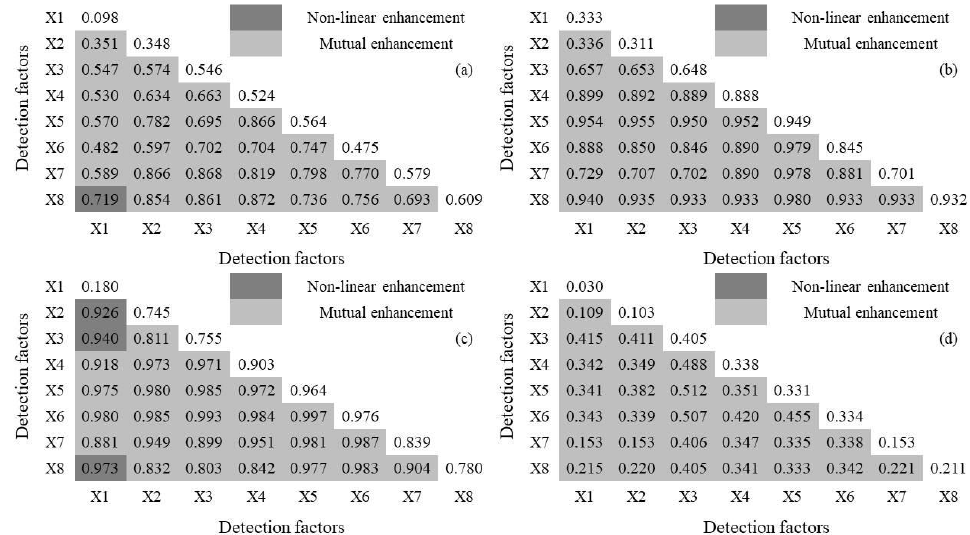
Figure 7. Interactions between meteorological factors (X1–X8 represent atmospheric pressure, sunshine, relative humidity, water vapor pressure, temperature, precipitation, wind velocity, and mean maximum temperature, respectively) on winter wheat in rain-fed areas in the ( a ) green-up, ( b ) jointing, ( c ) heading – filling, and ( d ) milk stages.